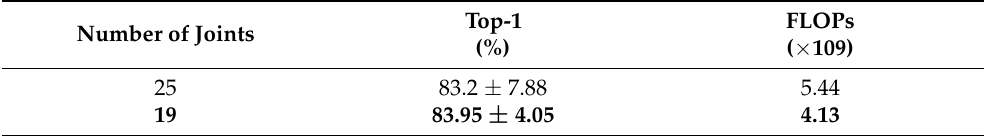
Table 2. Comparison of different numbers of joints.